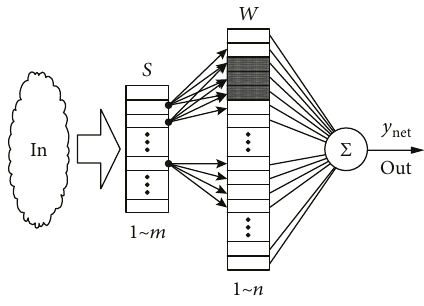
Figure 4: Structure of the CMAC neural